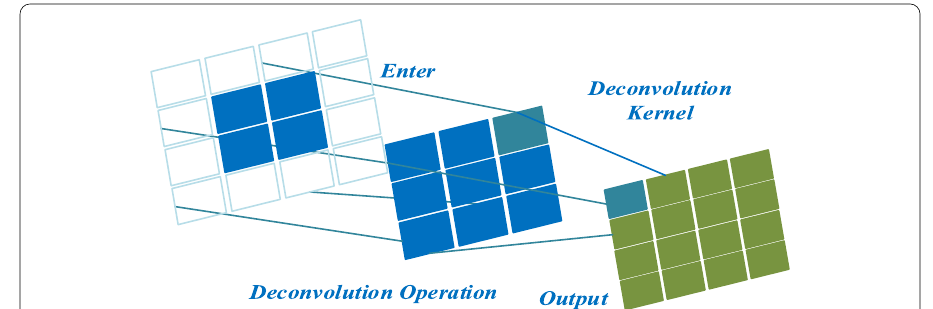
Fig. 3 Schematic diagram of convolution operation and transposed convolution